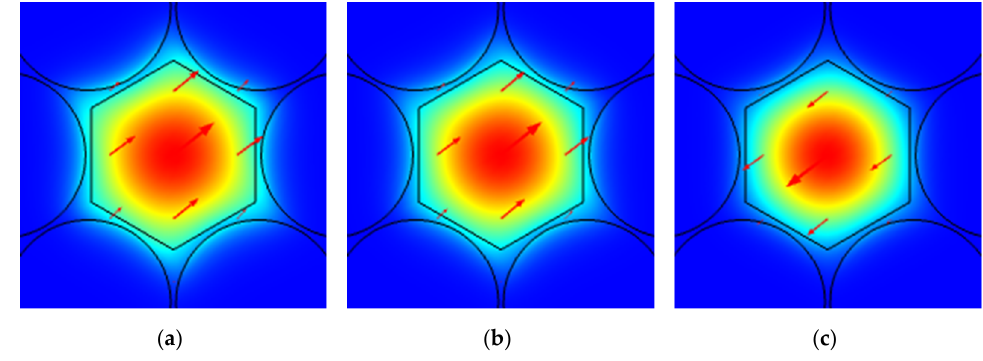
Figure 3. Mode profile of the proposed PCF for ( a ) water, ( b ) ethanol and ( c )